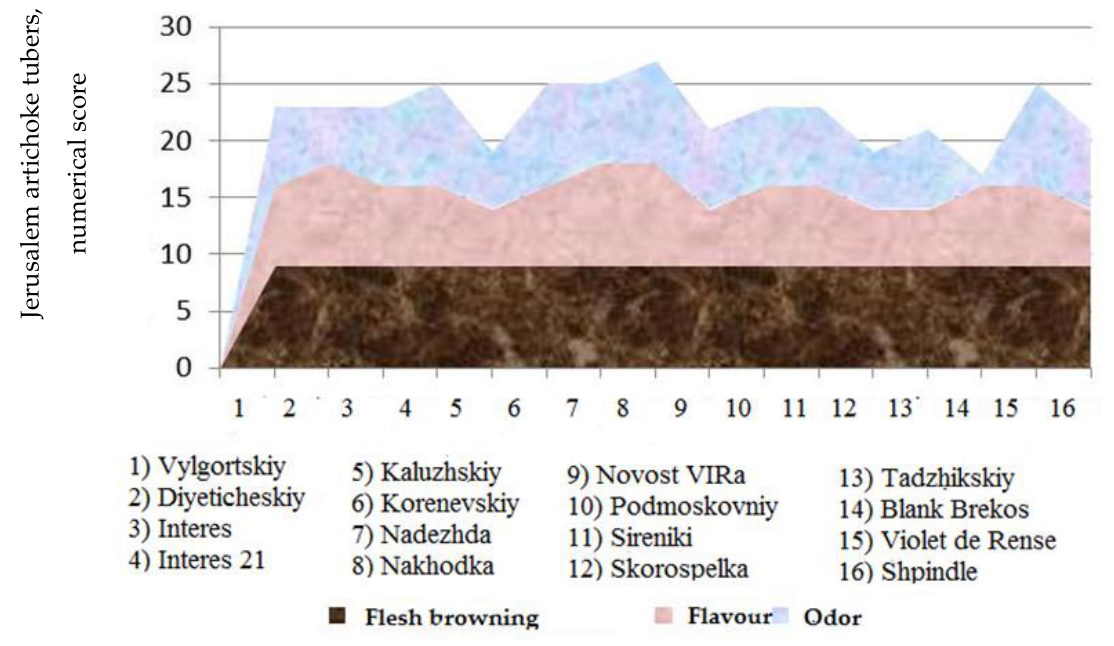
Figure 7. Technological qualities of raw Jerusalem artichoke tubers, numerical score. The energy costs and feed values were calculated in megajoules of metabolized energy (Figure